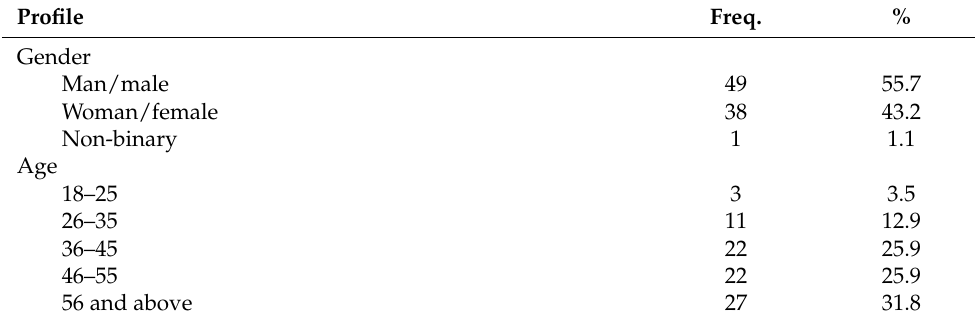
Table 1. The profile of survey